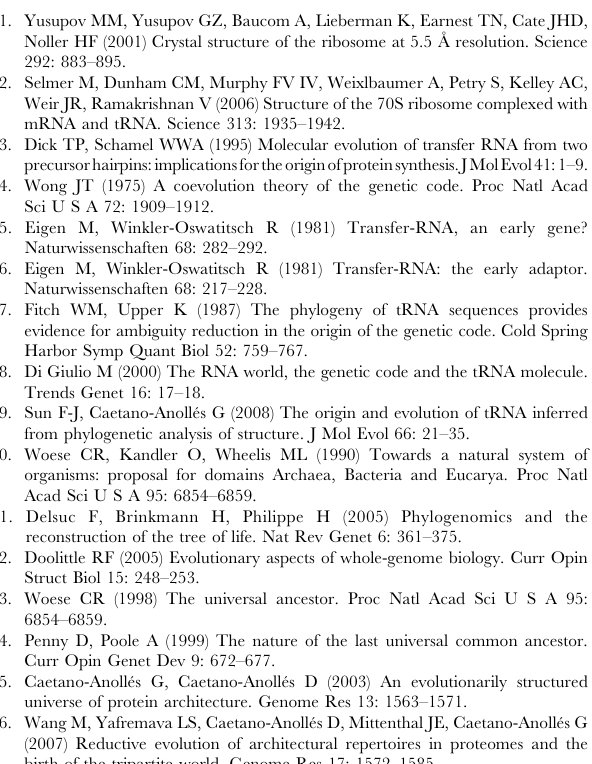
Table S2 Structural characters and their statistics (range and mean 6 standard deviation) used in the phylogenetic analyses of 571 tRNA